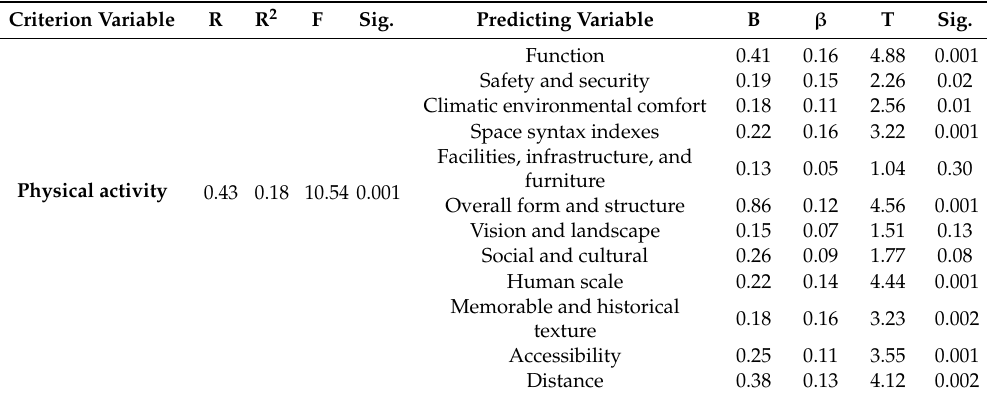
Table 9. Results of regression analysis test for predicting physical